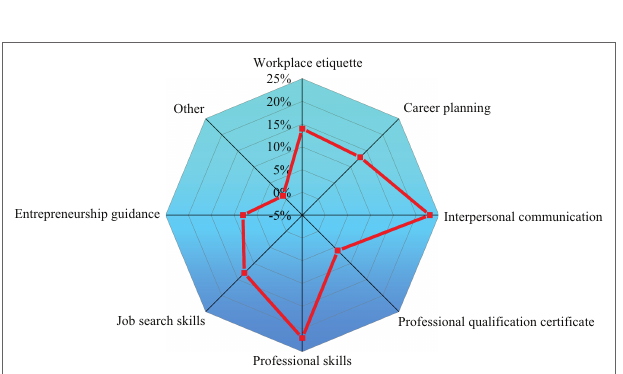
FIGURE 15 | The courses needed for the cultivation of applied innovative